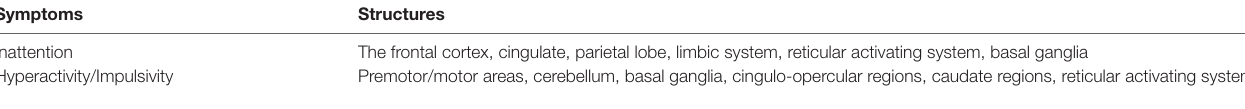
TABLE 1 | Typical ADHD symptoms and underlying